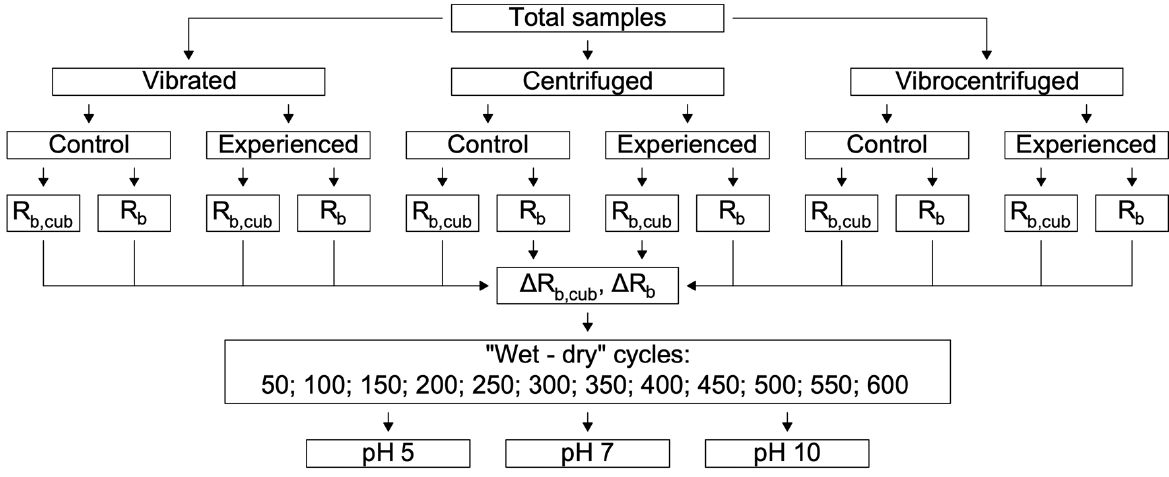
Figure 4. Block diagram of experimental studies.